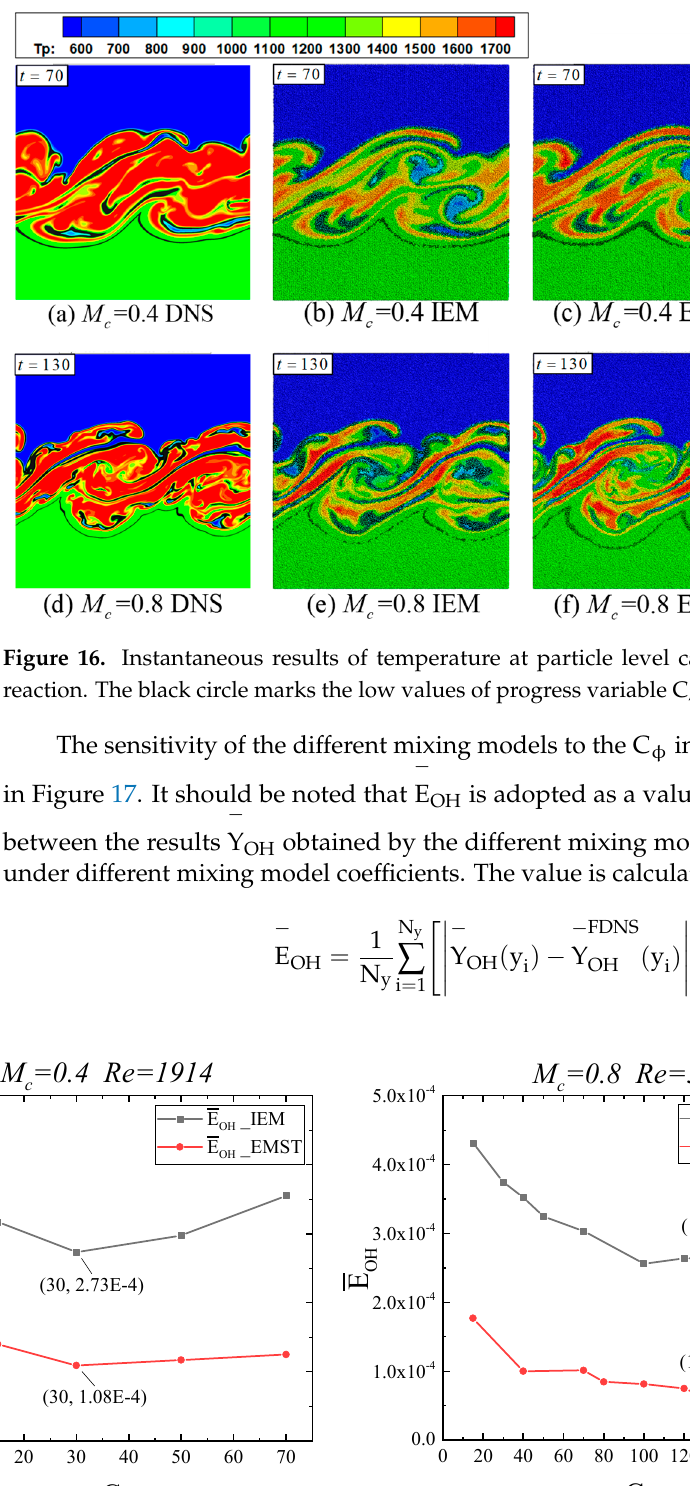
( d ) Figure 15. Probability density function of the progress variable at four moments: ( a ) t ∗ =60 in M c = 0.4 case, ( b ) t ∗ =70 in M c = 0.4 case, ( c ) t ∗ =120 in M c = 0.8 case, ( d ) t ∗ =130 in M c = 0.8 case. Figure 16 shows the location of lower values of progress variable C, i.e., 0.1 < C < 0.3 in instantaneous results of temperature, and lower C values are often associated with lower temperatures. The EMST model performs slightly better at predicting the temperature field as M c = 0.4. The distribution of the lower progress variable marked by the black circle shows few differences, as shown in Figure 16b,c. However, there are a